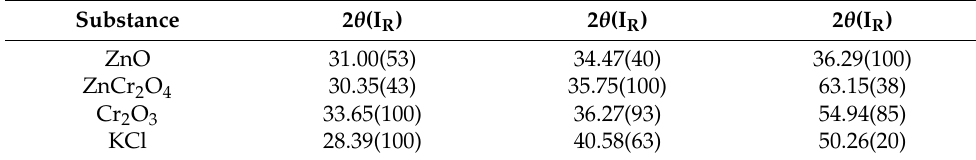
Table 3. Three highest peak data of standard diffractograms from AMCSD.